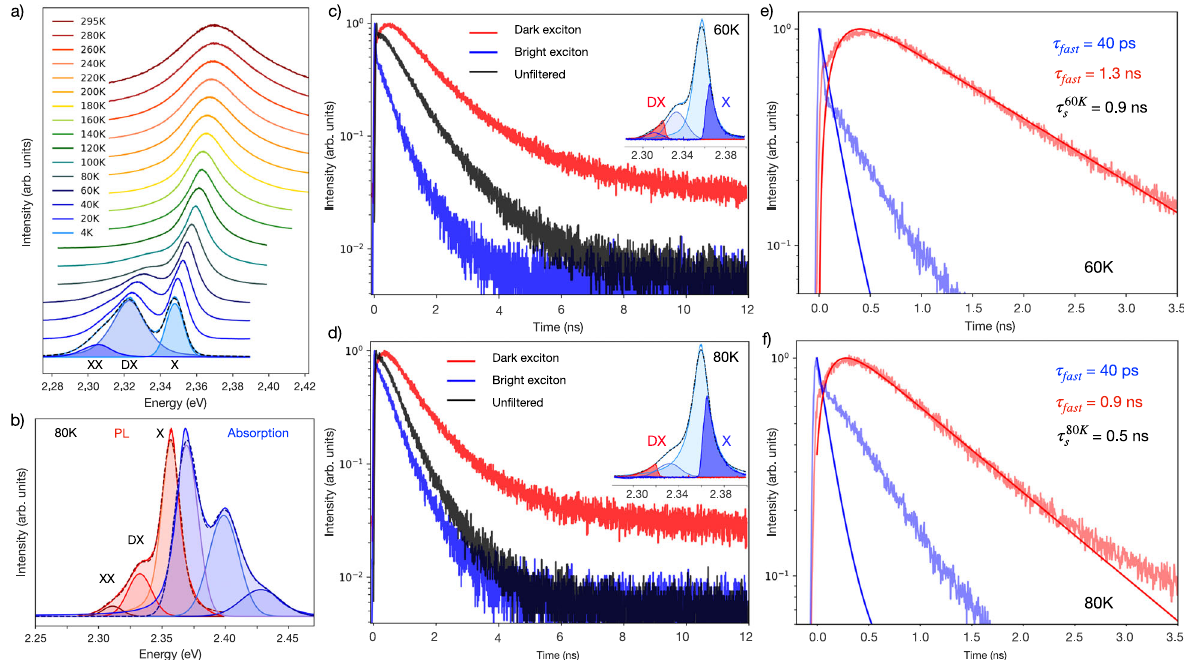
fi ltered spectrum (red). Insets: 2Dperovskite thin fi lmPLat c 60K and d 80K with fi tted Gaussian constituent peaks. High (dark blue) and low (dark red) energy regionshighlighted,showingtheexperimentallymeasuredPLspectrawithtunable edge-pass fi lters for X and DX decay measurements, respectively. e , f Lifetimes of the X emission (blue) and DX emission (red) simulated with Eqs. 3 –